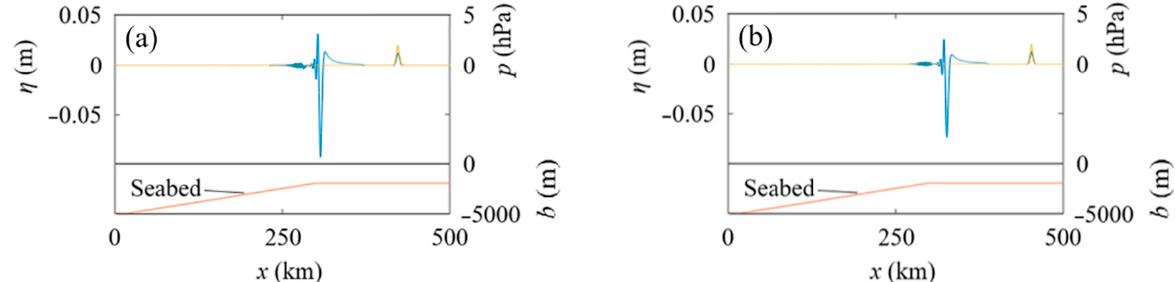
Figure 10. Water surface profiles at t = 1610 s for different values of x 1 in Case H, in which h on = 2000 m, x slope = 20 km, x on = 300 km, and the slope gradient β = 1.07 × 10 − 2 in Figure 2b. The blue, orange, and red lines indicate the water surface displacement η , atmospheric pressure p , and seabed position b , respectively. ( a ) x 1 = 25 km and ( b ) x 1 = 55 km in Figure 1.